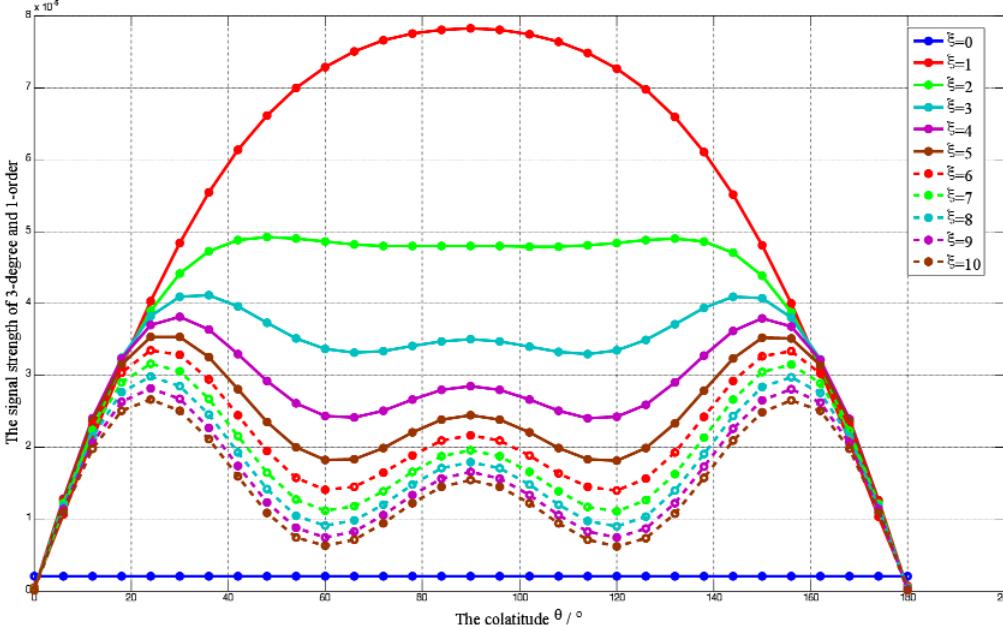
Figure 5. The signal strength of third-degree and first-order spherical harmonics at different co-latitudes (longitude, m = r